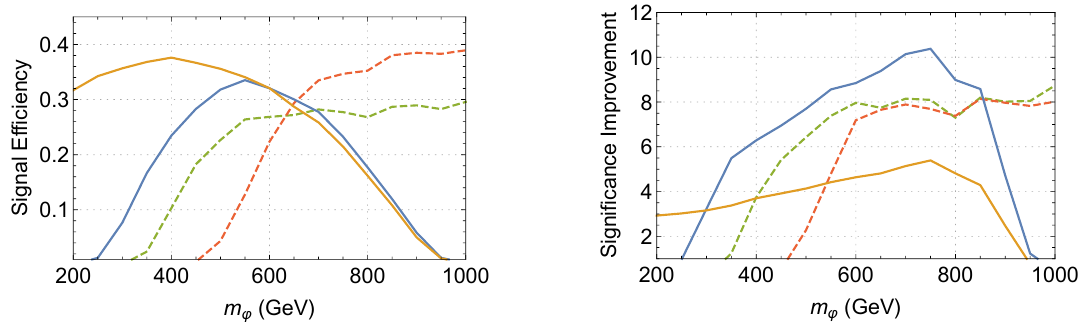
Figure 6. Tagger performance in terms of signal e(cid:14)ciency (left panel) and signi(cid:12)cance improvement (right panel) as a function of m ’ . Lines are color-coded in the following way: solid orange for Merged tagger (case 2), solid blue for Intermediate tagger (case 1), dashed red/green for Resolved W -taggers (case 0) with R = 0 : 5 (green) and R = 0 : 8